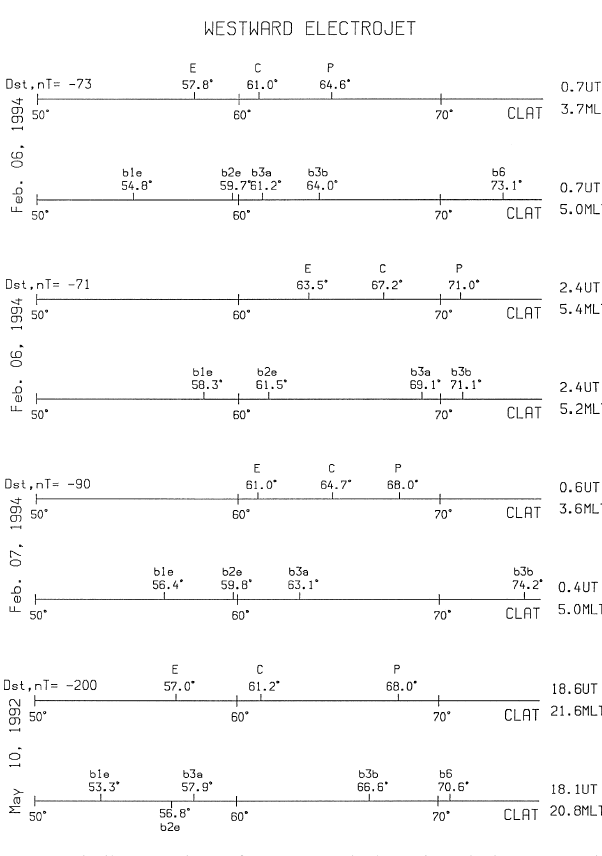
Fig. 6. Similar to Fig. 5 for westward electrojets during magnetic storms on February 06–07, 1994 and May 10, 1992 in the morning sector. In addition to plasma domain boundaries b 1– b 3 the position of b 6 boundary is shown; b 6 is the poleward boundary of subvisual drizzle